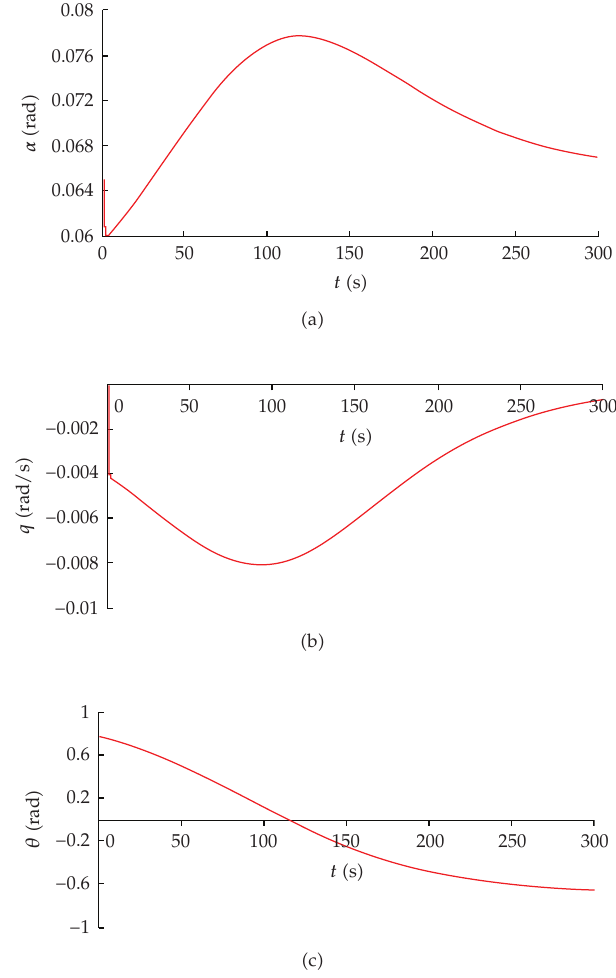
Figure 4: A transfer of an equilibrium, which belongs to P 2 into an equilibrium, which belongs to P 1 (cid:3) simulated in the simplified model (cid:4) : δ (cid:6) (cid:7) − 0 . 03866 (cid:5) rad (cid:6) (cid:7) 2 . 216 ◦ → δ (cid:6)(cid:6) e (cid:7) 0 (cid:5) rad / s (cid:6) ; θ (cid:6) (cid:7) 0 . 7674624 (cid:5) rad (cid:6) (cid:7) 43 . 994 ◦ → α (cid:6)(cid:6) 0 . 064883 (cid:5) rad (cid:6) (cid:7) 3 . 719 ◦ ; q (cid:6) 2 2 (cid:7) 0 (cid:5) rad / s (cid:6) ; θ (cid:6)(cid:6) (cid:7) − 0 . 6980667 (cid:5) rad (cid:6) (cid:7) − 40 . 016 ◦ instead of α (cid:6) q (cid:6)(cid:6) 1 1 (cid:7) 0 . 7674624 (cid:5) rad (cid:6) (cid:7) 43 . 994 ◦ → α (cid:6)(cid:6) (cid:7) 0 . 046845 (cid:5) rad (cid:6) (cid:7) 2 . 685 ◦ ; q (cid:6)(cid:6) θ (cid:6) 2 2